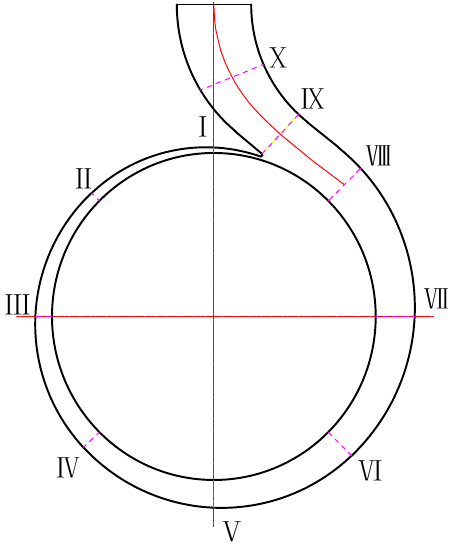
Figure 16. The positions of the cross sections.